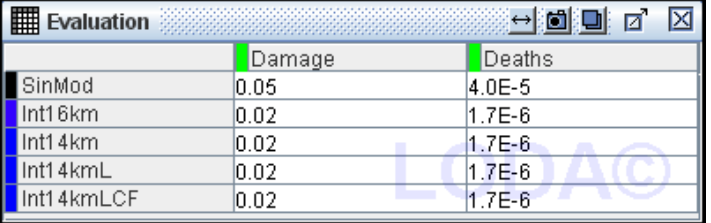
Figure 3. Safety